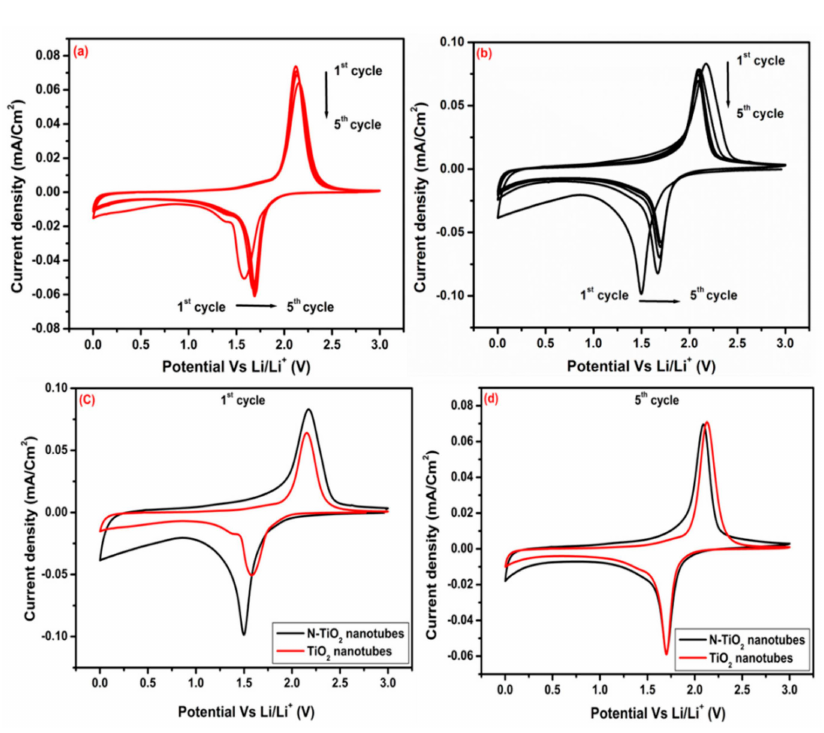
Figure 9. Cyclic voltammetry of ( a ) TiO 2 nanotubes and ( b ) N-TiO 2 nanotubes for 5 cycles, respectively, comparing CV of both samples ( c ) 1st cycle and (d) 5th